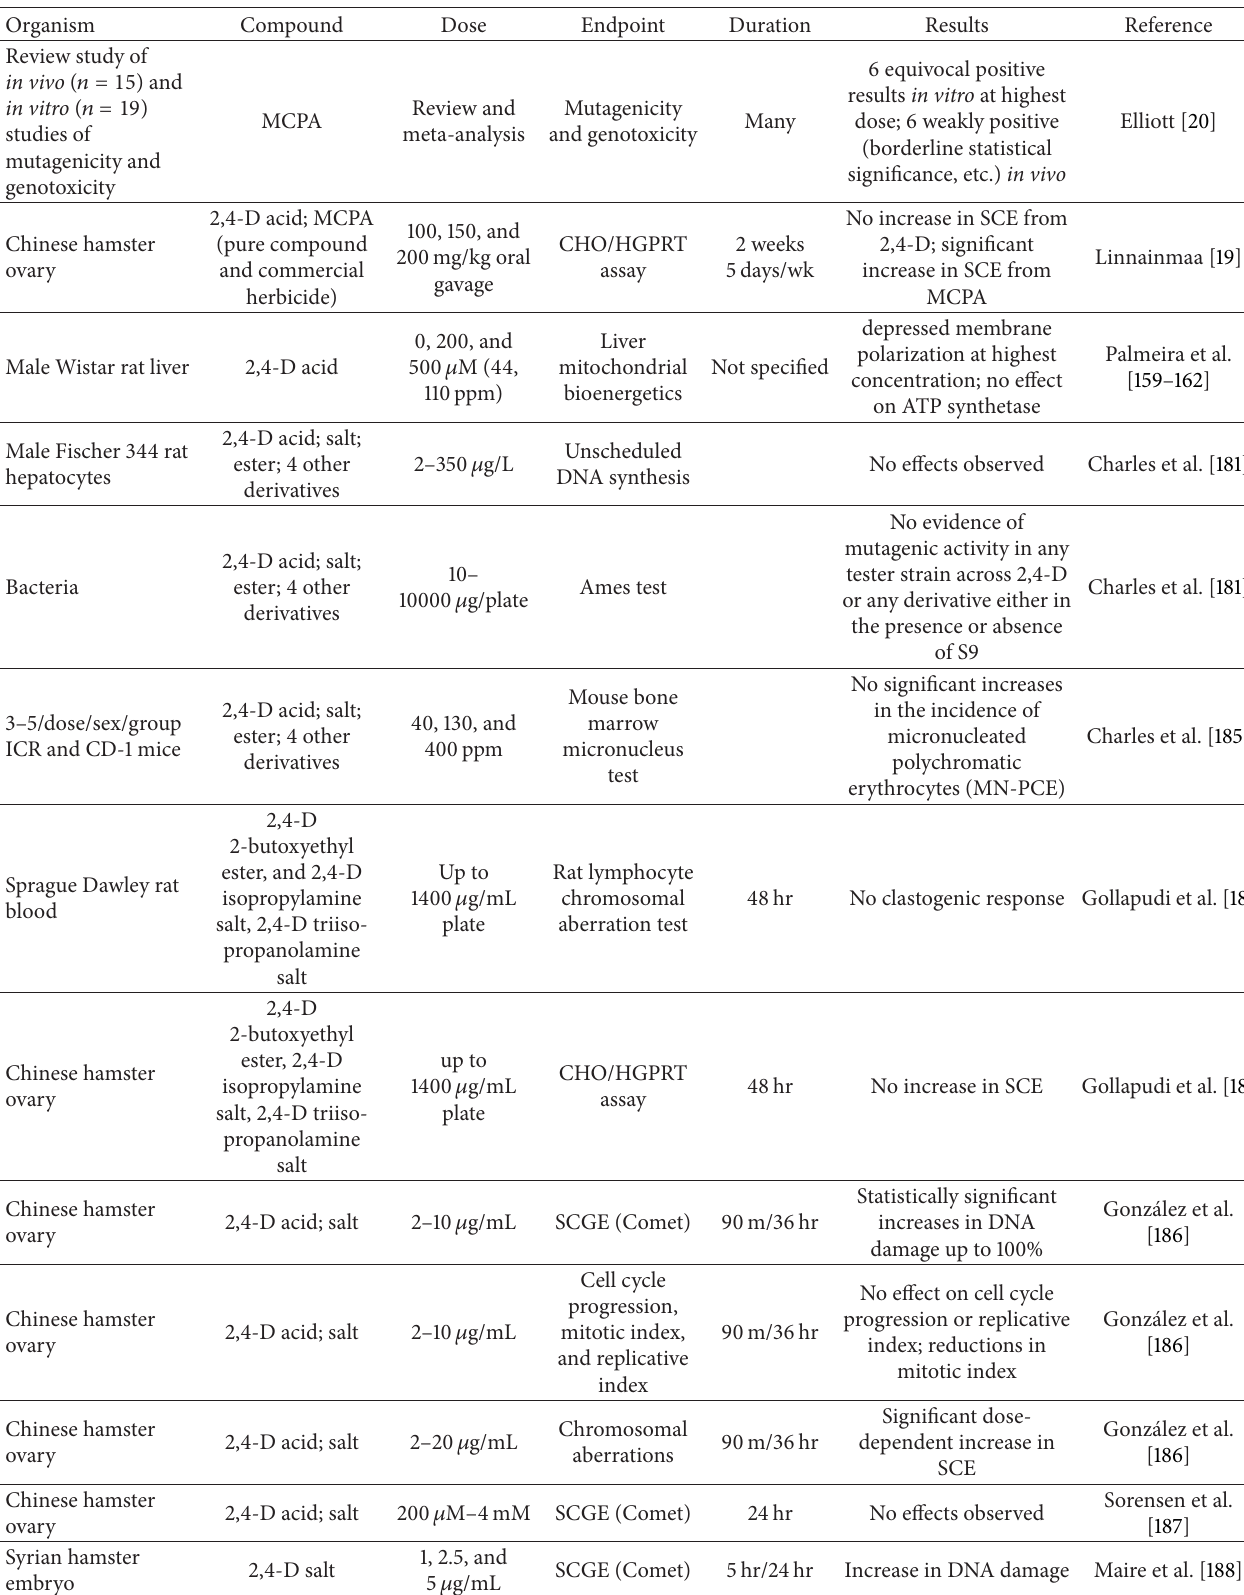
Table 7: In vitro animal